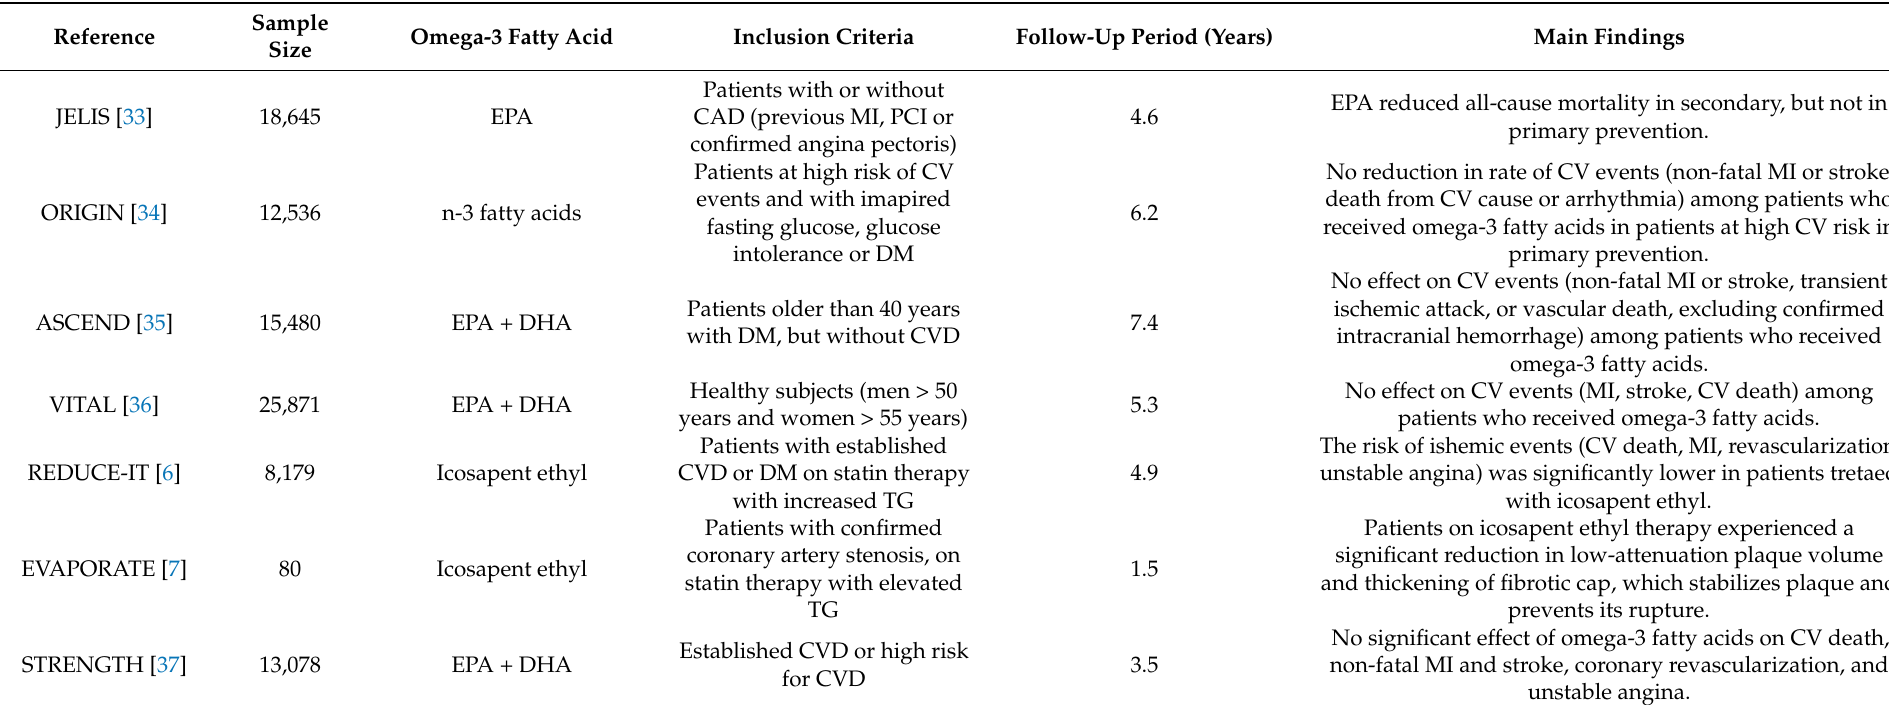
Table 1. The overview of the largest clinical trials about omega-3 fatty acids and cardiovascular